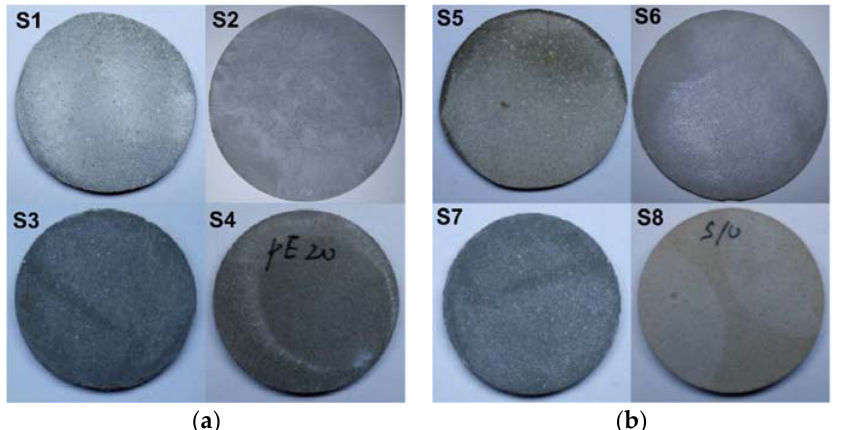
Figure 4. Sample characteristics for composite materials with ( a ) wollastonite and ( b ) wollstonite and muscovite.